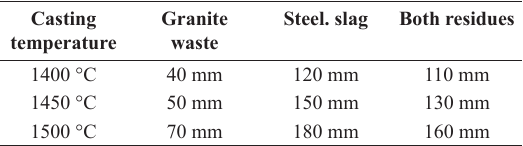
Table 3. Herty Viscosity Tests: results of the distance traveled by each batch prior to solidify. Casting Granite Steel. temperature waste